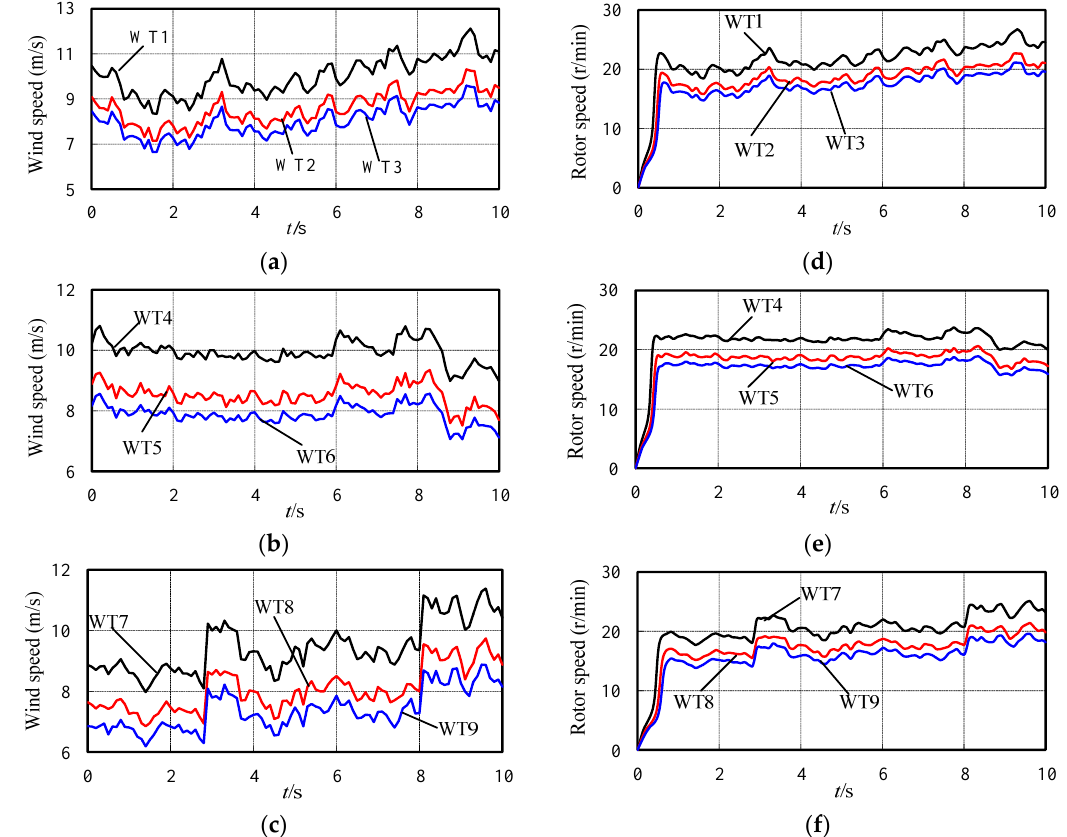
Figure 9. Time histories of the wind speed and rotor speed in the wind farm under the maximum power point tracking (MPPT) control. ( a ) Wind speed of the first group WTs (1–3). ( b ) Wind speed of the second group WTs (4–6). ( c ) Wind speed of the third group WTs (7–9). ( d ) Rotor speed of the first group WTs (1–3). ( e ) Rotor speed of the second group WTs (4–6). ( f ) Rotor speed of the third group WTs (7–9).